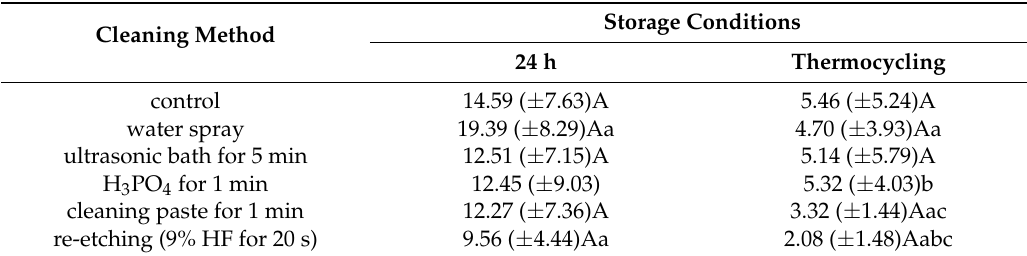
Table 1. Mean shear bond strength values (MPa) ± standard deviation for leucite glass ceramics (Avante) after different cleaning methods. Within cleaning methods, means followed by different letters (uppercase letters in line and lowercase letters in column) indicate significant statistical differences.